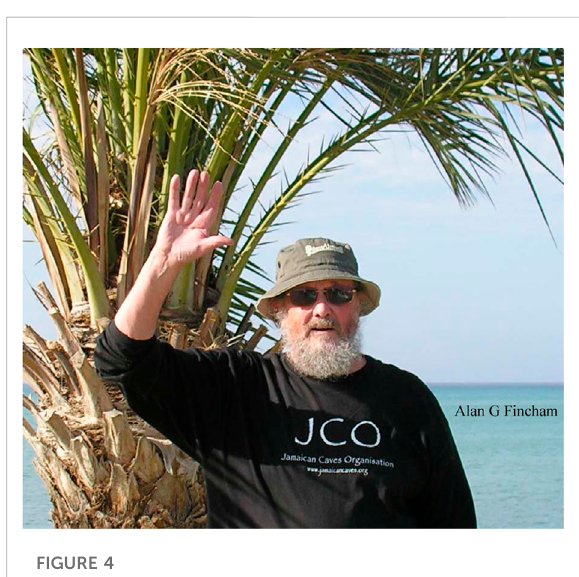
FIGURE 4 Alan Fincham ( † 16 May 2017, Cyprus) wearing a T-shirt from the Jamaican Caves Organization. Photograph dated approximately 2015, sent electronically by Dr. Fincham to